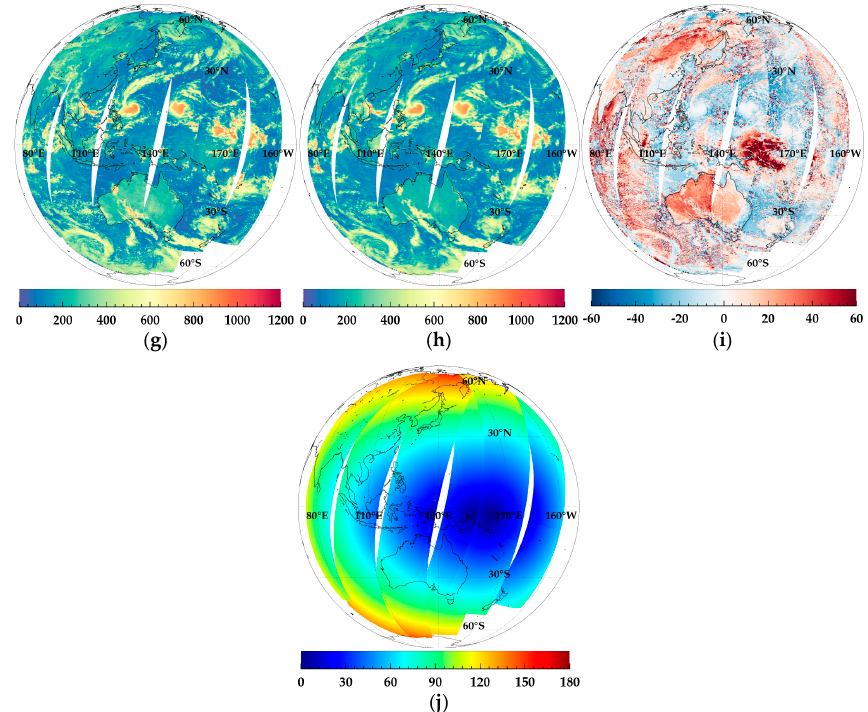
Figure 4. Red–Green–Blue (RGB) composite imagery ( a – c ); and RSR ( d – f ) of Himawari-8/AHI at 0000, 0300, 0600 UTC on 15 October 2015. The cyan circle and black circle (transparency = 50%) represents areas where sun glint (SG) ≤ 20°. Spatio-temporal matched RSR (Wm − 2 ) of: AHI ( g ); and CERES ( h ) on this date; and percentage error (%) of: two dataset sets ( i ); and sun glint (SG) angle ( j ).